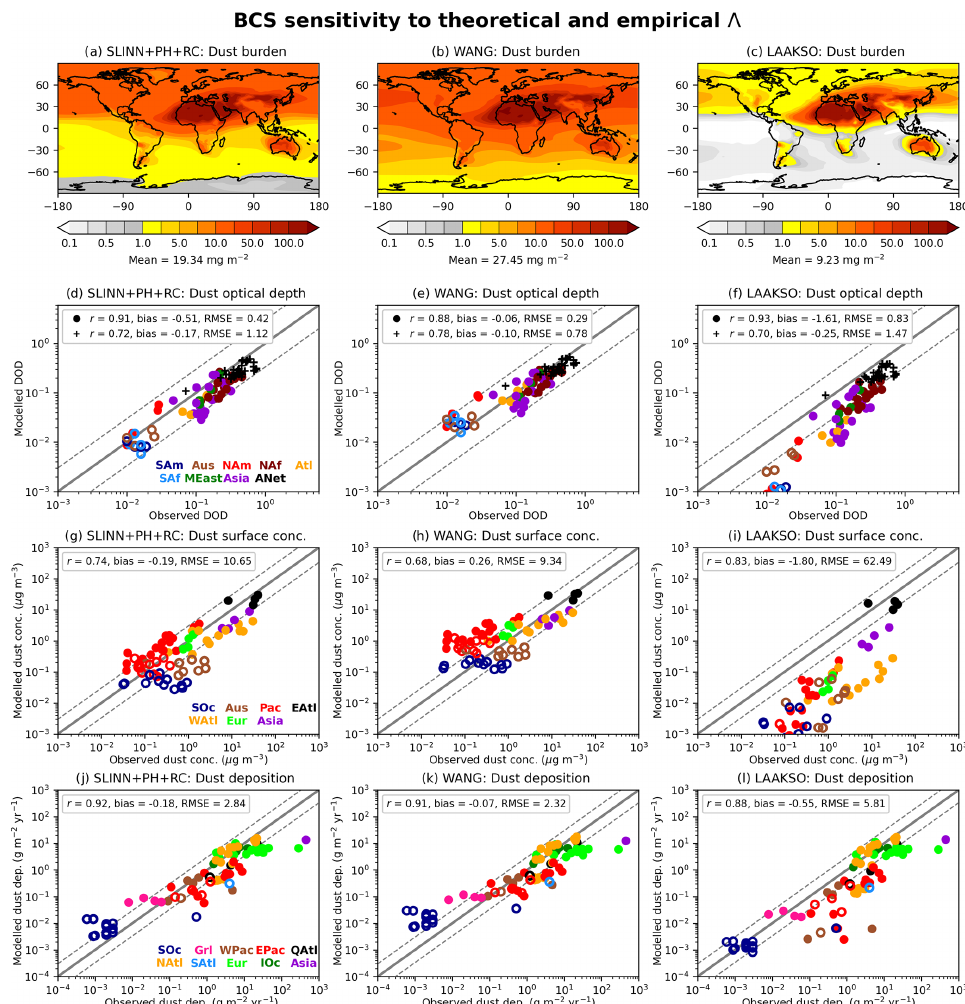
Figure 7. Global dust metrics in the SLINN + PH + RC, WANG, and LAAKSO simulations, used to answer KQ1 – empirical vs. theoretical BCS schemes. (a–c) Annual-mean total dust burden, (d–f) seasonal and regional dust optical depths (DOD) against 440nnm AERONET observations ( + ) and 550nm DODs from Kok et al. (2021), (g–i) seasonal and regional near surface dust concentrations against U-MIAMI observations (Prospero and Nees, 1986), and (j–l) annual-mean regional dust deposition rates against observations from Huneeus et al. (2011). Filled and unfilled circles refer to Northern and Southern Hemisphere measurements respectively. Colours in (d–l) denote different regions, with abbreviations provided in Tables S3–S4 for (d–f) and Table S5 for (g–i) . For (j–l) , the abbreviations are as follows: SOc –